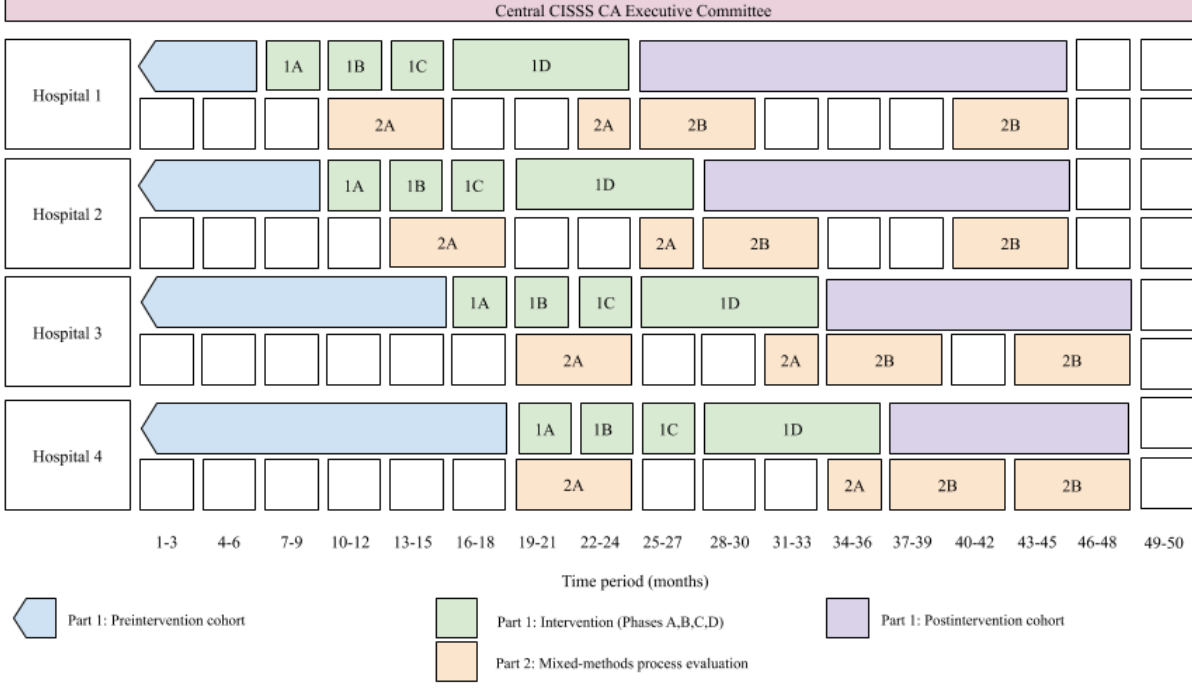
Figure 1. Study timeline. Staggered implementation of the context-adapted CISSS-CA ACE intervention across four hospitals and parallel mixed-methods process evaluation. ACE: Acute Care for Elders; CISSS-CA: Centre intégré de santé et de services sociaux de Chaudière-Appalaches (Chaudière-Appalaches Integrated Health and Social Services Centre).